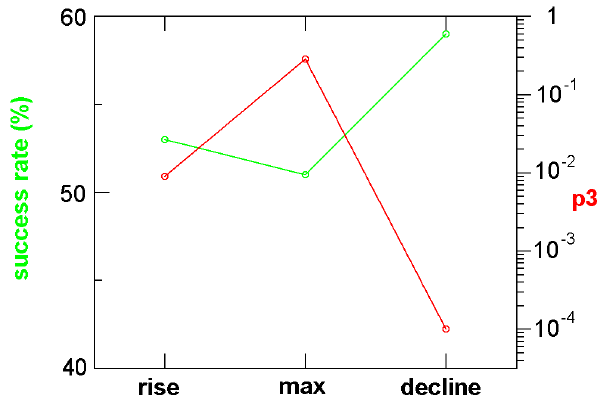
Fig. 1. The success rate sr (in green, left co-ordinate) and p 3 (in Figure 1. The success rate sr (in green, left co-ordinate) and p3 (in red, right co-882 red, right co-ordinate) plotted for the events measured during each ordinate) plotted for the events measured during each of the three phases of solar cycle 883 of the three phases of solar cycle 23 (see Table 3). 23 (see Table 3). 884